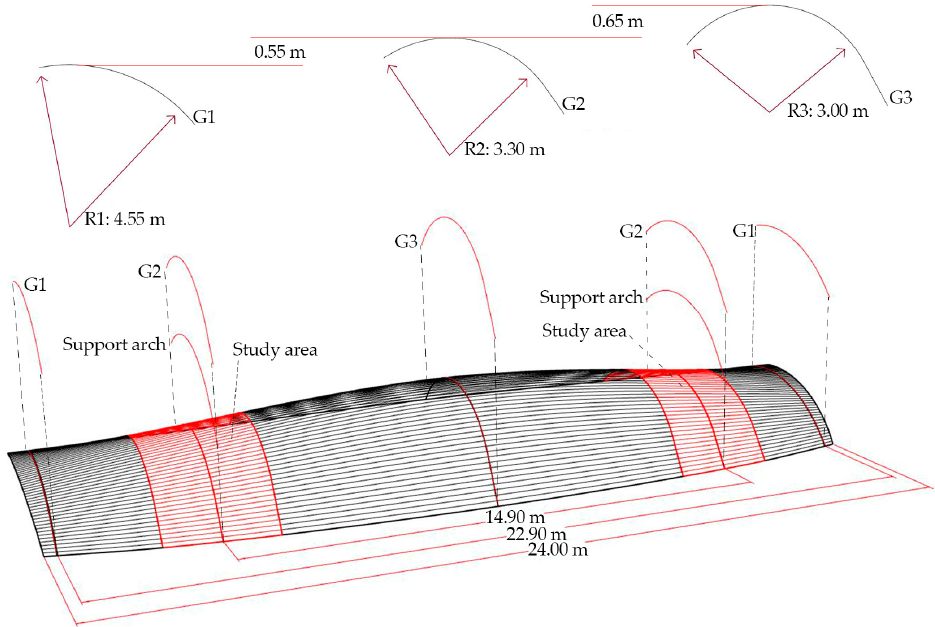
Figure 16. PEMADE gridshell. Geometric definition of the target surface and study area.